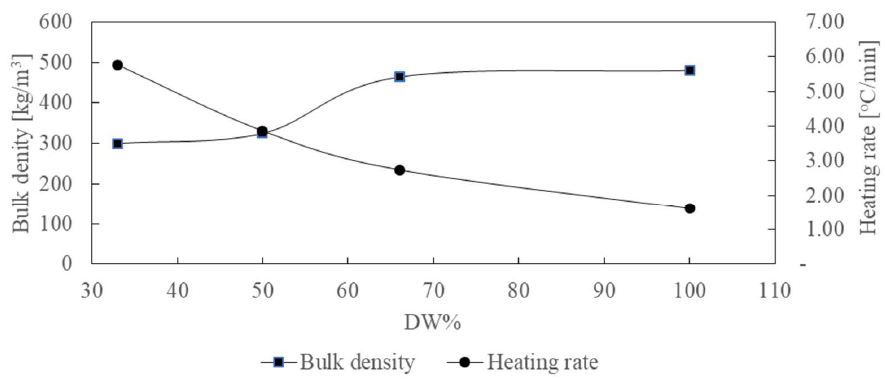
Figure 4. Characteristics of bulk density and heating rate for different proportions of dis- tillery waste in the